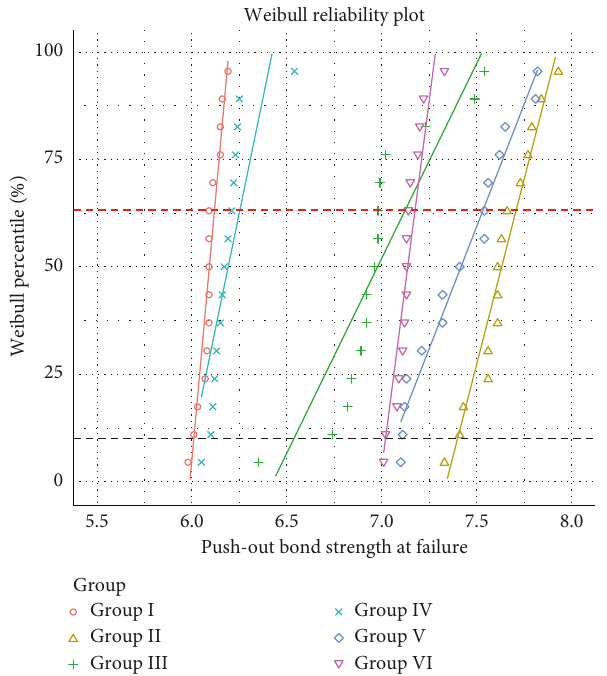
Figure 1: Weibull plots for push-out bond strength and different segments of root